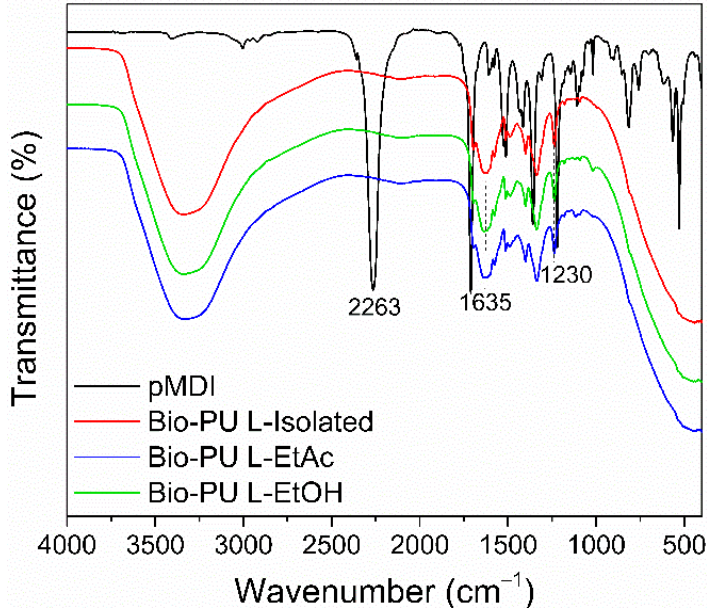
Figure 3. FTIR spectrum of lignin-based Bio-PU. There was no peak at wavenumber 2263 cm − 1 in LPU resins. It is possible to assume that the NCO group in pMDI interacted seamlessly with the OH group on lignin to create stretching vibration of the O–H group may be seen in a wide range. The additional between lignin and NaOH, utilized as a solvent in this study. In LPU resins, a typical peak at wavenumber 1635 cm − 1 indicated the structure of C=O group from the urethane bond. A substituted mono amide and C-H bending were formed with a wavenumber of 1553–1500 cm − 1 . A cyclohexane N–H group has a wavenumber of 1341 cm − 1 , while the C–N group has a wavenumber of 1250–1020 cm − 1 [58,60]. This spectrum illustrates